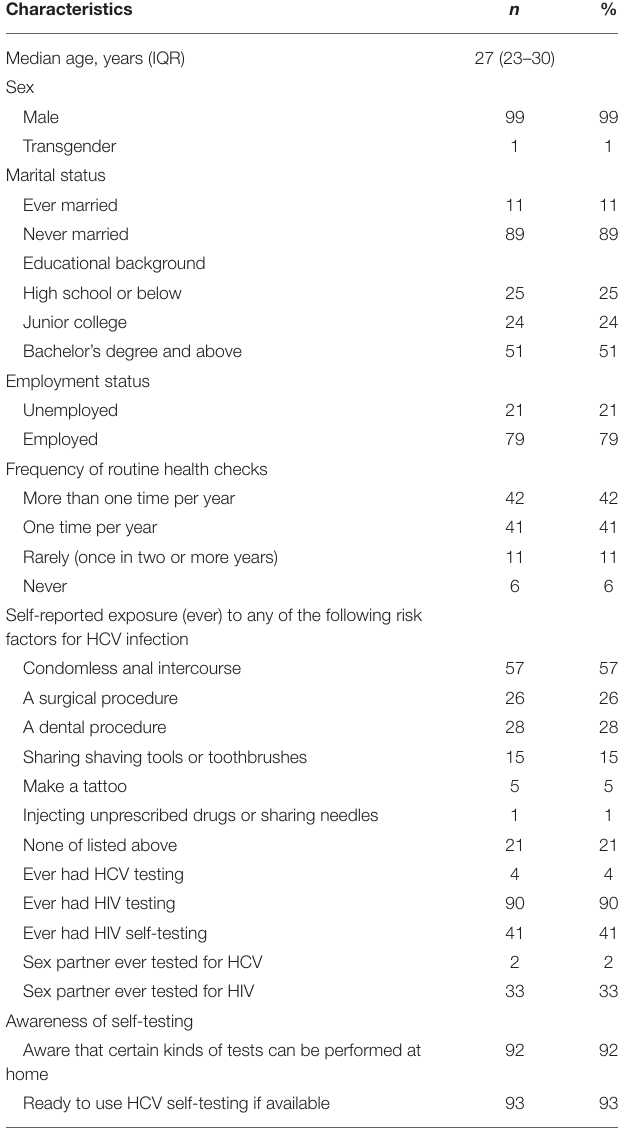
TABLE 1 | Baseline demographic characteristics among MSM, an observational study in China, 2019, N = 100.